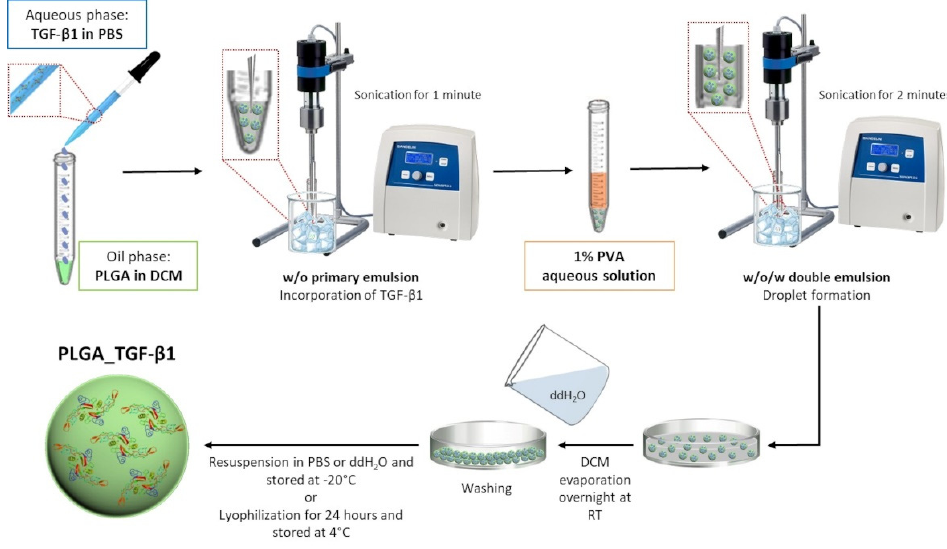
Figure 1. Schematic representation of PLGA_TGF- β 1 synthesis process.